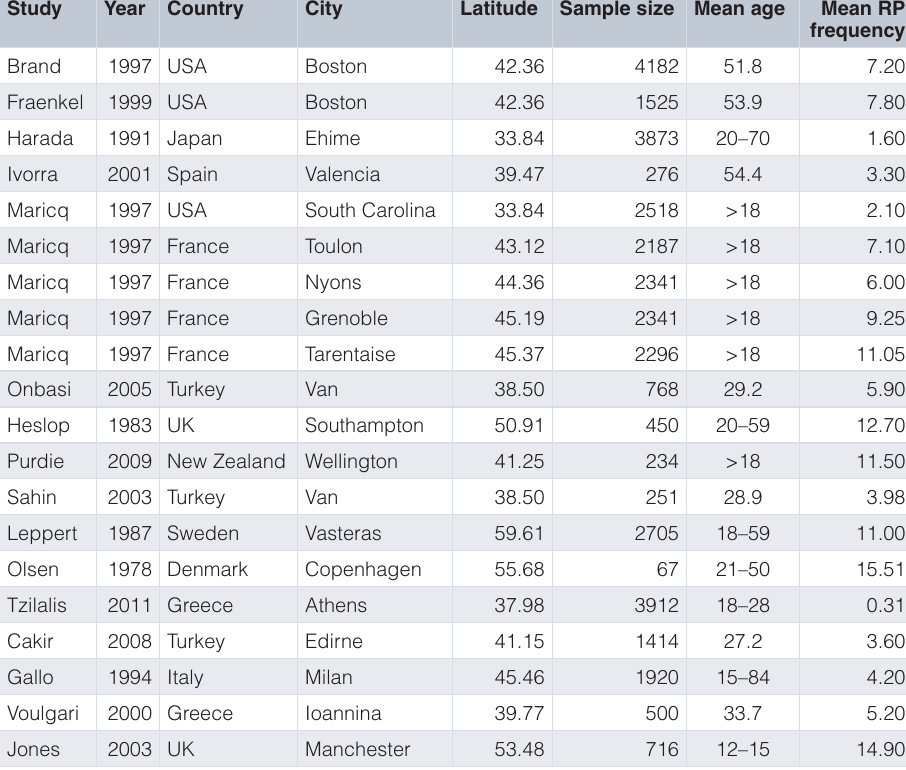
Table 1. Extracted data from the systematic review of Garner et al. 9 . Data is reproduced under the terms of the Creative Commons Attribution Non Commercial (CC BY-NC 4.0).